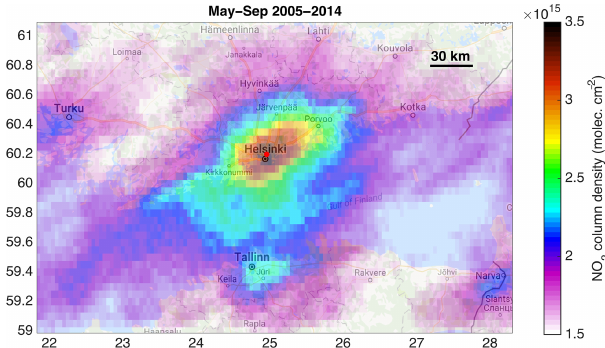
Figure 1. OMI NO 2 tropospheric column in Helsinki. The map shows the average over the time period 2005–2014 from May to September with 0 . 05 ◦ × 0 . 05 ◦ spatial resolution. The location of the ground-based station is shown as a red